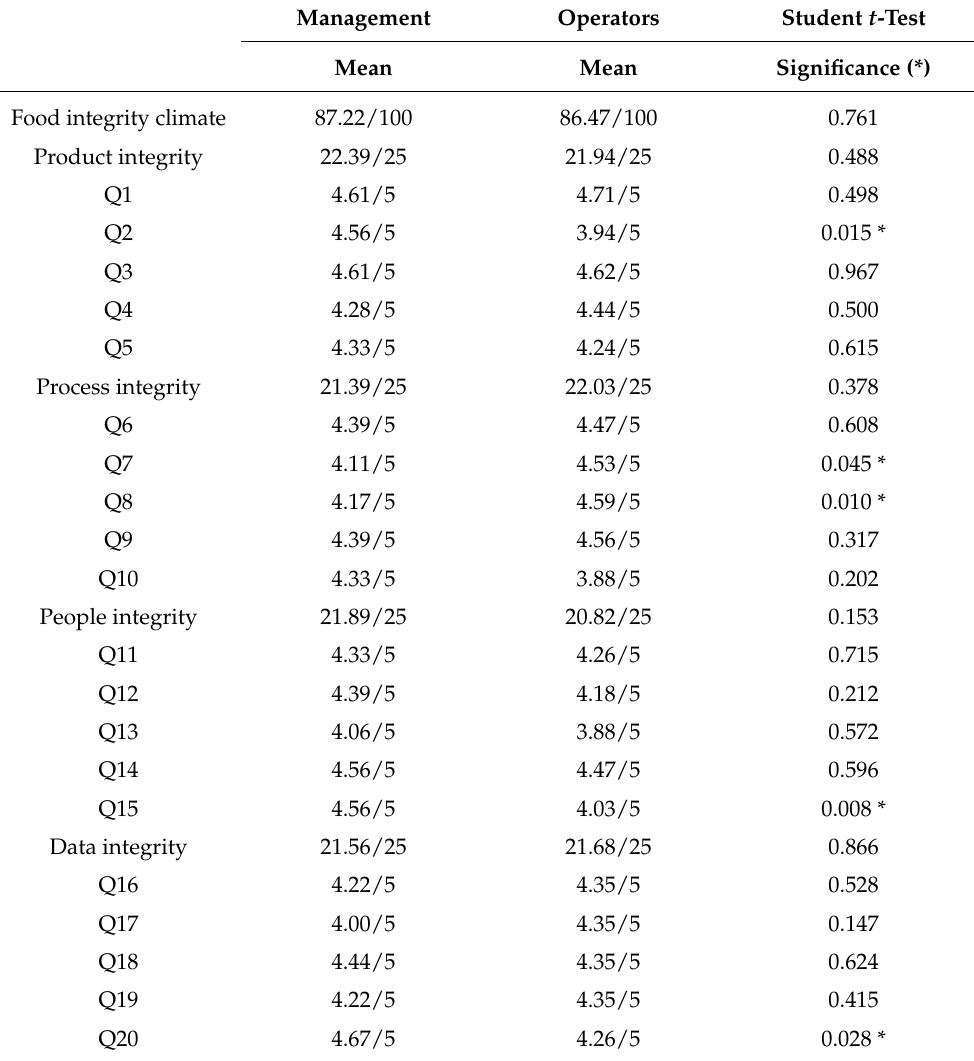
Table A1. Overview of mean scores (overall, dimension-specific, and indicator-specific) and student t-test results of the food integrity climate as perceived by managers ( n = 18) and operators ( n = 34) of the large-scale meat distribution company participating in the testing of the FIC